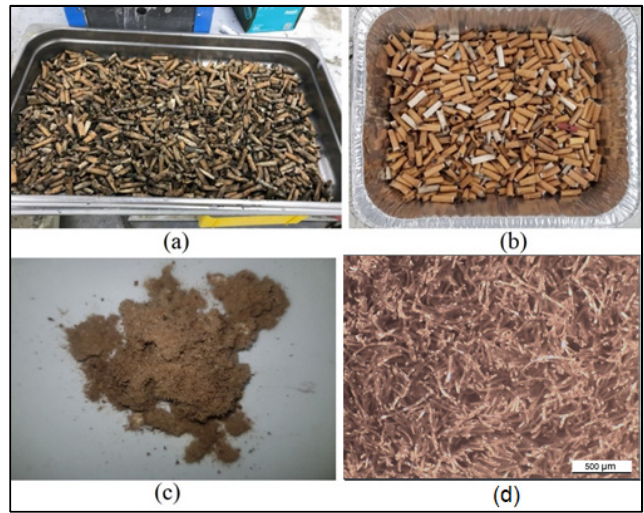
Figure 5. Cigarette butts ( a ) before and ( b ) after oven drying and the removal of excess tobacco and dirt; ( c ) ground cigarette butts (CBs) used for sample preparation; ( d ) view of CB fibers under optical microscope.